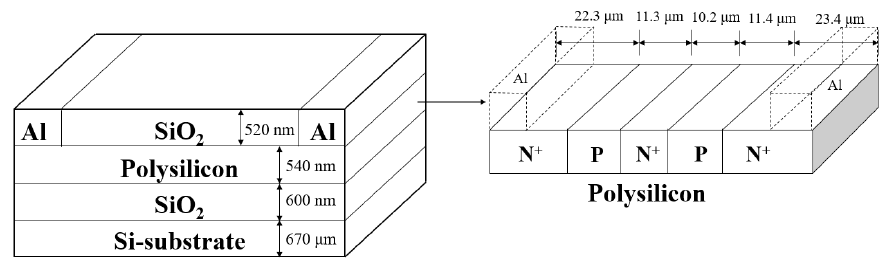
Figure 2. The structure of the polysilicon light source.